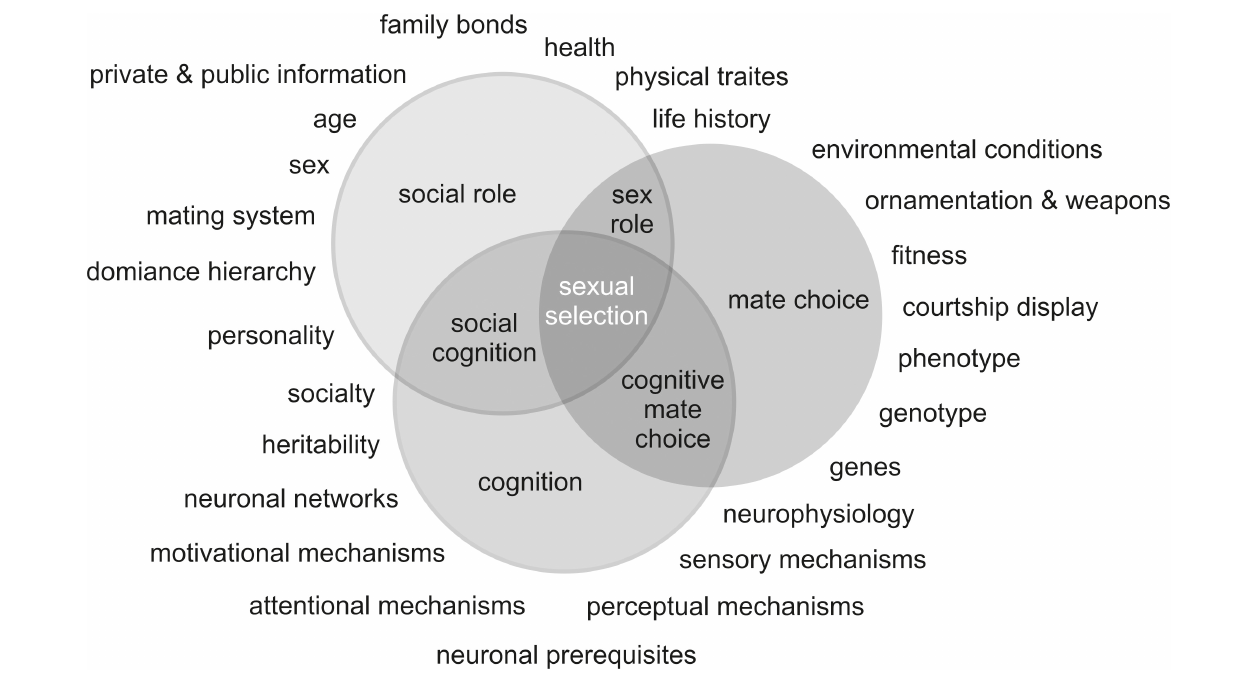
FIGURE 1 | Mate choice, cognition, and social roles converge on social cognition, cognitive mate choice, and sex roles, which are mutually dependent on one another as well as on various powerful determinants, and represent important determinants of sexual selection.